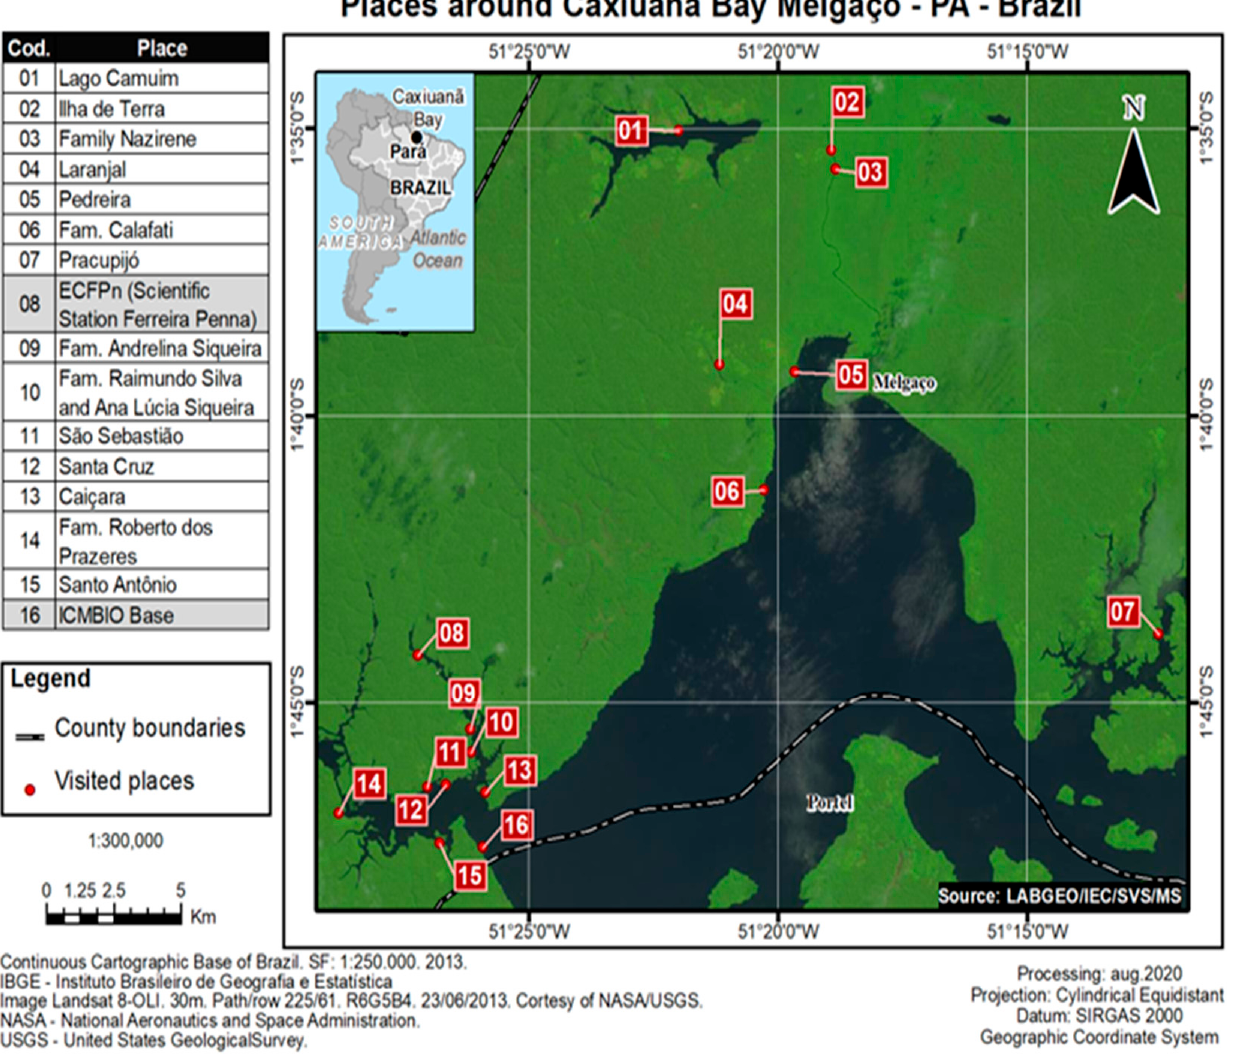
Figure 1. Description of the studied areas in the Caxiuanã National Forest.